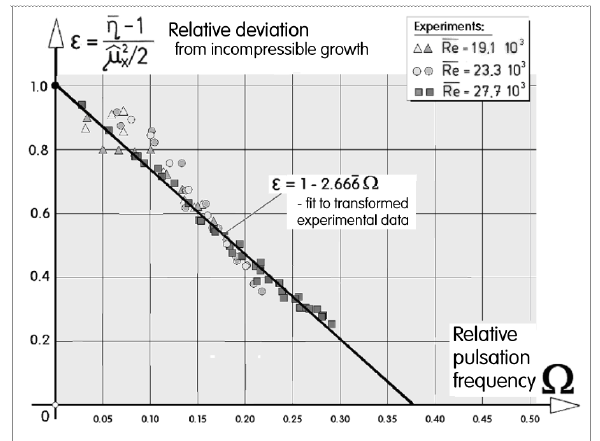
Demonstration of the correctness of the explanation of the pressure decrease in Fig. 15 by the damping effect of the inevitable air-accommodating chamber C in Fig. 15. There is a universal linear law for the compressibility effect as a function of the relative pulsation